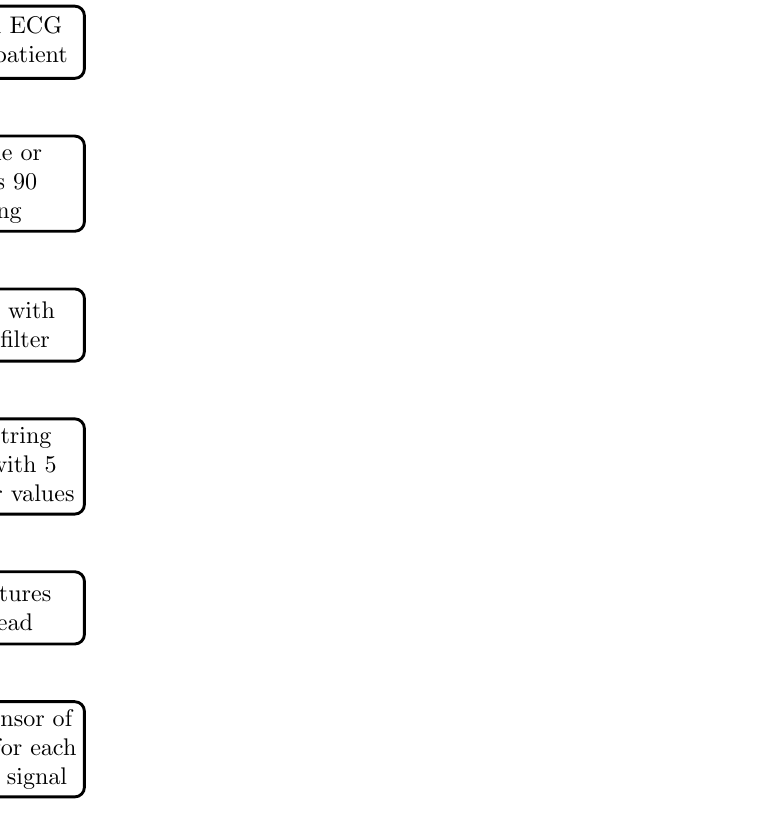
Figure 3. Construction of tensors from the PhysioNet PTB dataset for each patient.